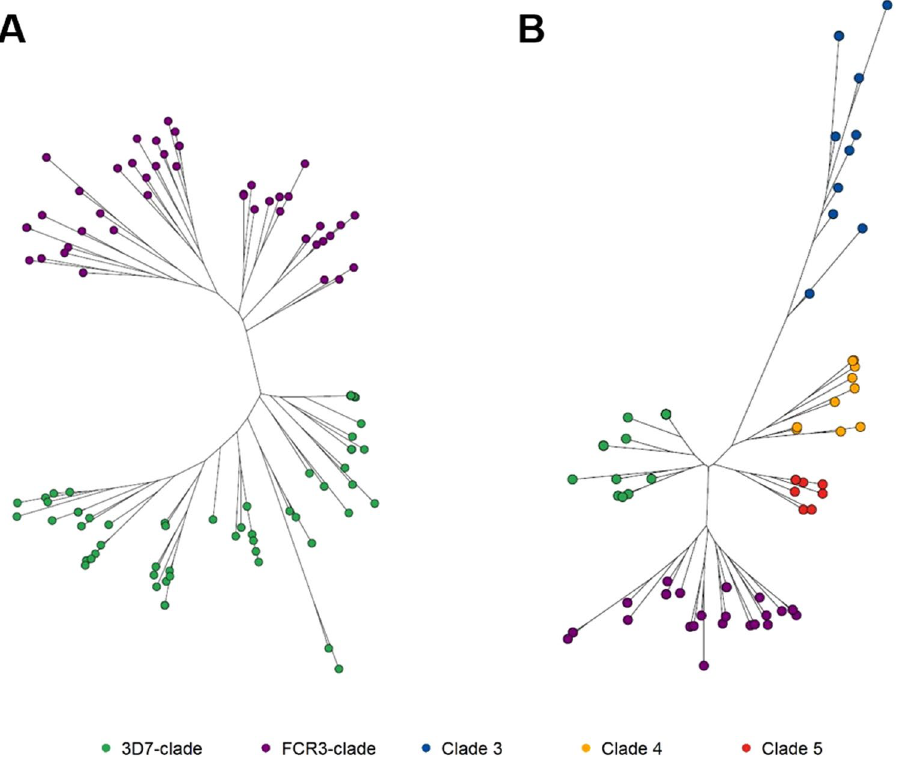
Figure 4. Maximum-likelihood phylogenetic trees of ID1-DBL2x variants in ( A ) Malawi and ( B ) Benin. All trees were bootstrapped 1000x and bootstrap values > 80 were used as cutoff points for significant branch differentiation. In Malawi, variants clustered in two distinct clades with the two referent strains (3D7 and FCR3). In Benin, in addition to the 3D7 and FCR3 clades, three other clades were detected.